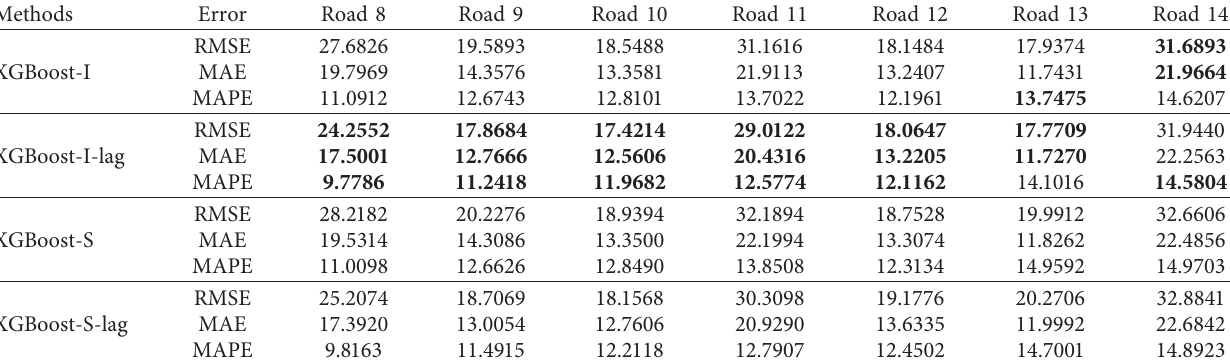
Table 5: Down-direction-related XGBoost models’ prediction